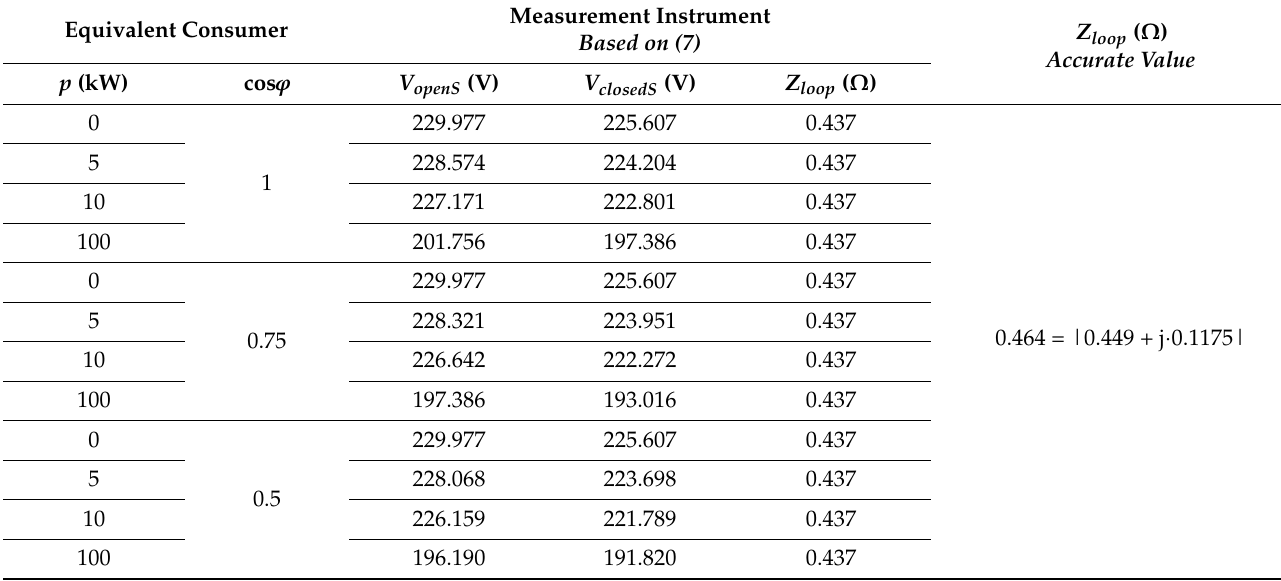
Table 6. The 100-kVA transformer and L = 500 m for cable 3.